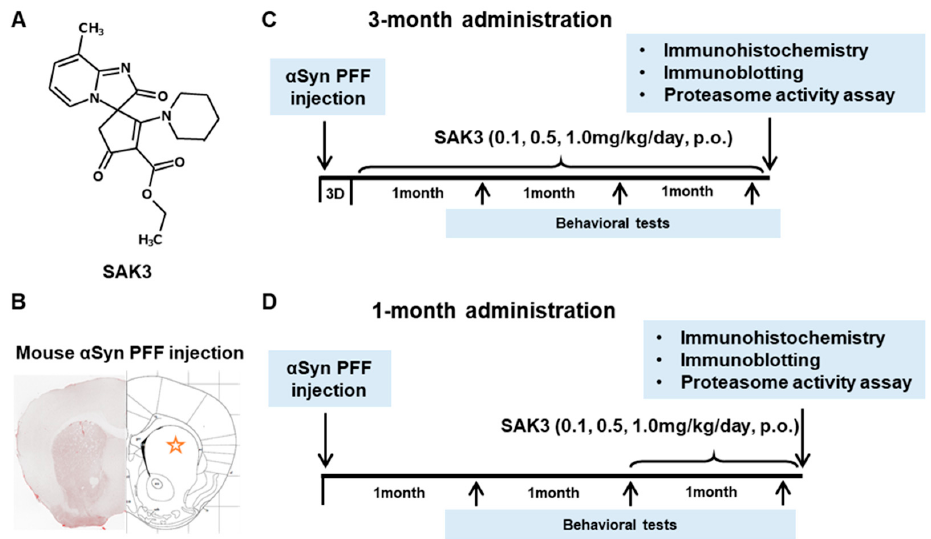
Figure 1. Chemical structure of SAK3, experimental schedule, and α -Synuclein PFF injection area. ( A ) Chemical structure of SAK3. ( B ) Position of PFF injection in the mouse brain striatum. Experimental schedule of ( C ) 3-month chronic administration or ( D ) 1-month administration of SAK3 in this study.